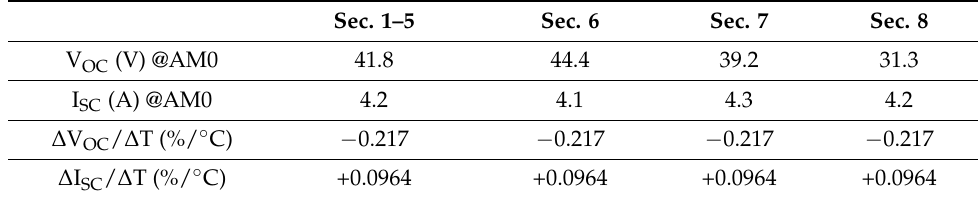
Table 2. Electrical parameters of the solar array sections.